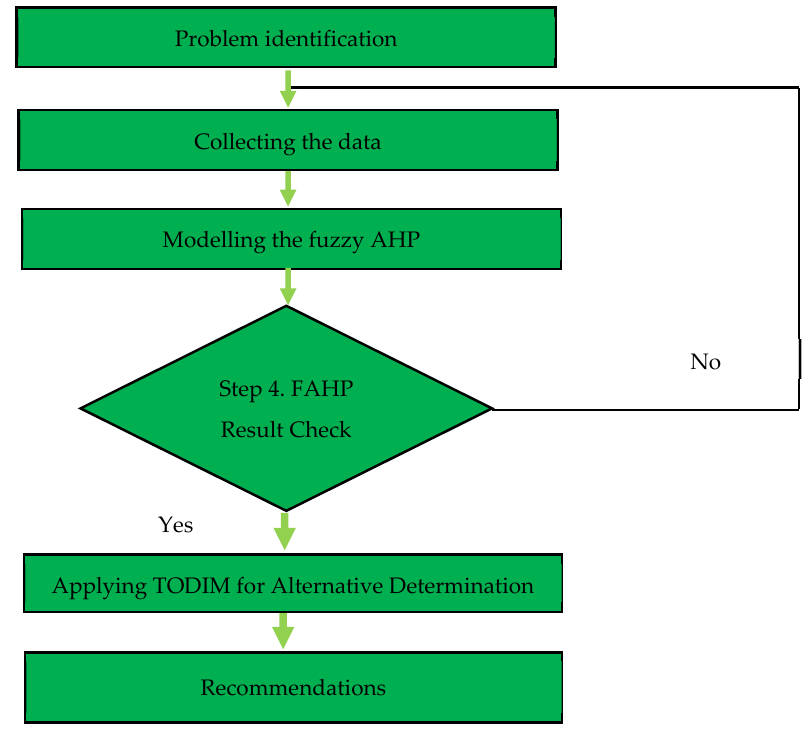
Figure 1. Research Figure 1. Research graph.